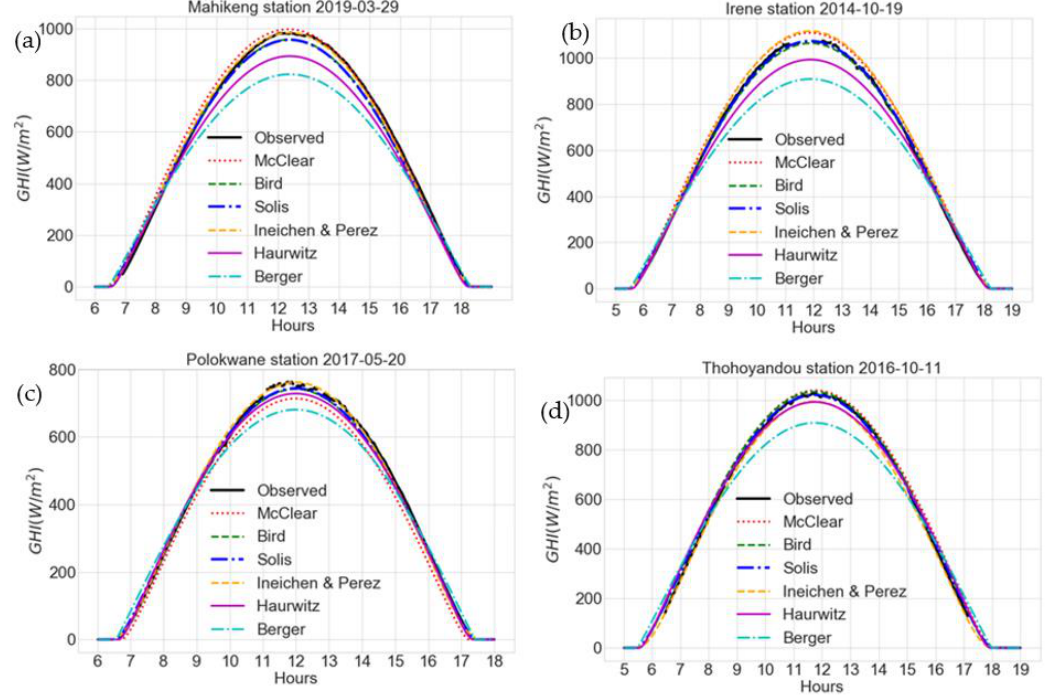
Figure 7. Comparison between observed and modelled minute GHI values in Mahikeng ( a ), Irene ( b ), Polokwane ( c ), and Thohoyandou ( d ).